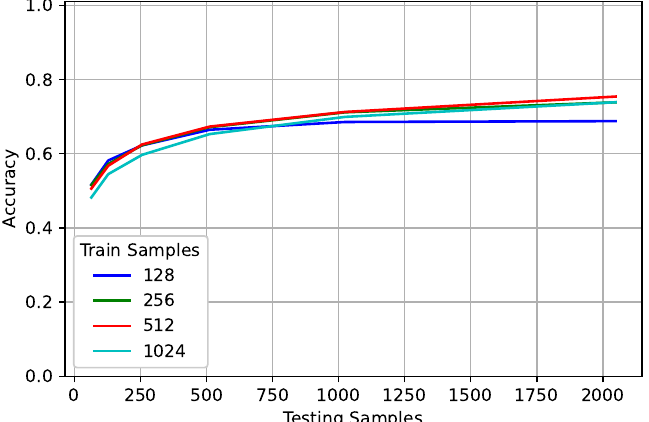
Figure 3. The nuisance networks trained on different sequence lengths were compared to each other for different testing sequence lengths. For the same trained sequence length, evaluating on a longer sequence length increased the PCC with diminishing returns. For the same sequence length in evaluation, networks trained on a sequence length close to the the evaluation sequence length typically performed